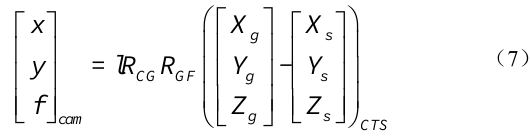
R and R represent the rotate matrix from the where, CG GF orbital coordinate system to the sensor coordinate system and from the Earth fixed coordinate system to the orbital coordinate system respectively; (x, y, f) is the coordinate of the centre image-point of each strip image in the sensor coordinate system. R is calculated via equation Matrix GF